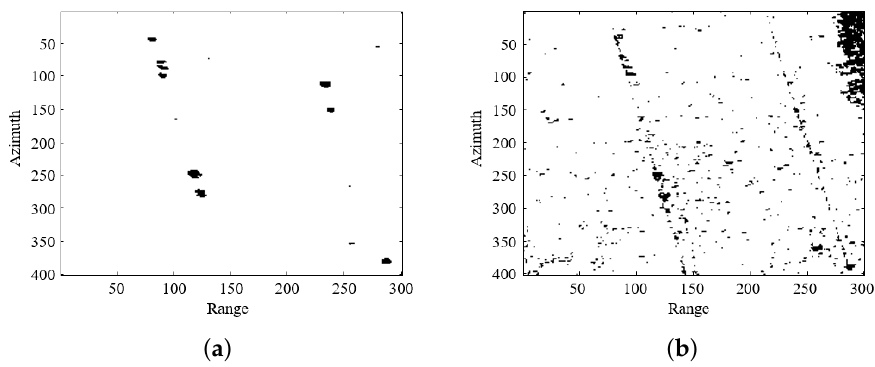
by vegetation in the scene.